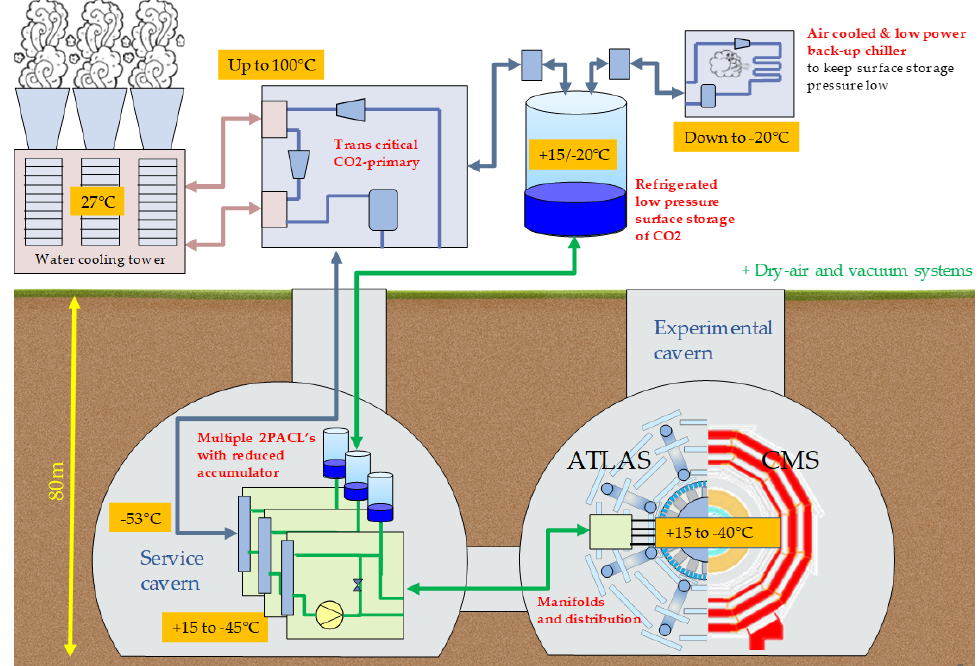
Figure 1. Overview of ATLAS and CMS cooling system pipeline connections and distribution. Underground, the pressure of the R744 primary shall be as low as possible at the evaporator level to cool the liquid CO 2 pumped by the 2PACL secondary loop down to lowest possible temperature. The physical limit is of course − 56.6 °C, corresponding to the CO 2 triple point at 5.2 bar): therefore, the challenge translates into minimising that safety margin, protecting from the risk of getting below the triple point due to the pressure drop along the line. Moreover, with non-insulated pipes at room temperature and such low return pressure, the superheating of the return line will be significantly large ( ≈ 70